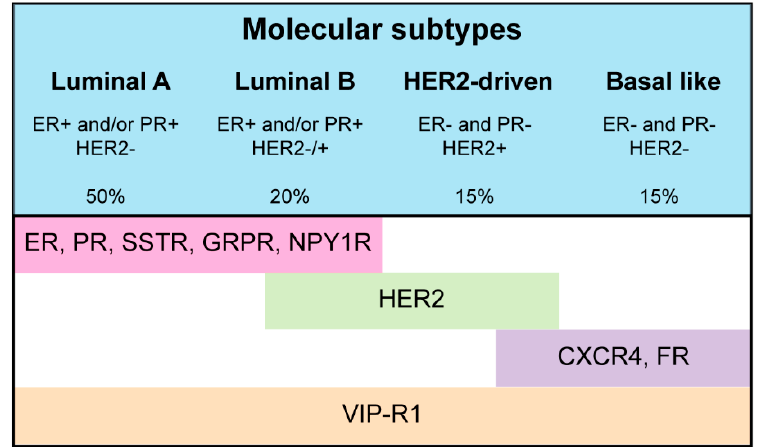
Figure 5. An overview of targets discussed in this review and the breast cancer subtype with highest expression thereof. ER: estrogen receptor, PR: progesterone receptor, SSTR: somatostatin receptor, GRPR: gastrin releasing peptide receptor, NPY1R: Neuropeptide Y receptor Y1, HER2: human epidermal factor receptor 2, CXCR4: C-X-C chemokine receptor type 4, FR: folate receptor, and VIP-R1: Vasoactive intestinal polypeptide receptor 1. Details on histological and molecular profiles are derived from [107].